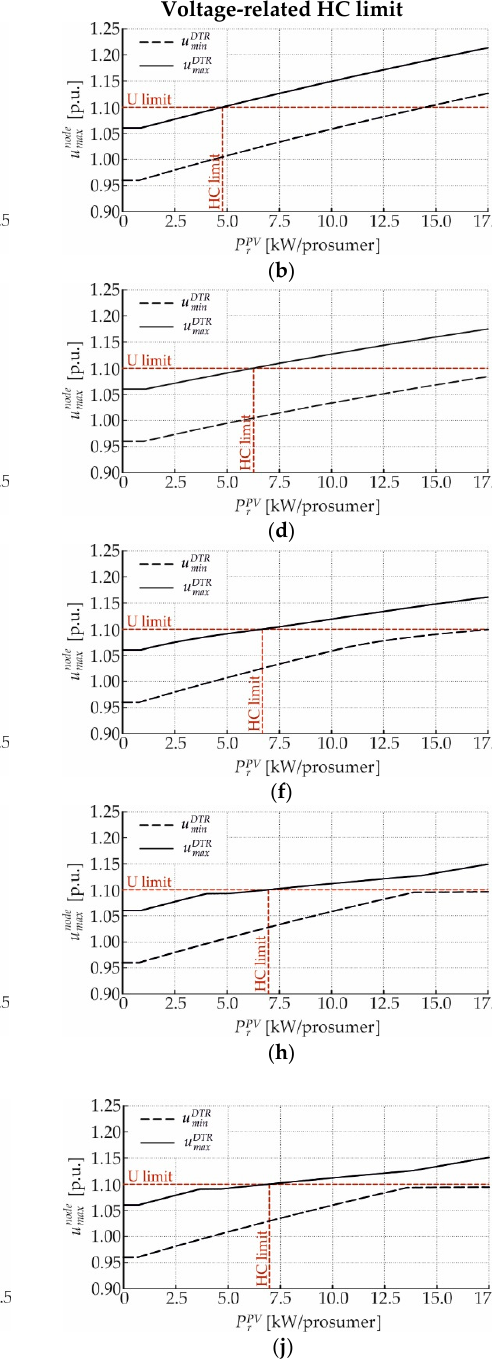
Figure 15. Current- and voltage-related hosting capacity limits of the branched cable test-feeder for different control strategies: ( a , b ) no-control; ( c , d ) cos φ ( P )-control; ( e , f ) Q ( U )-control; ( g , h ) L ( U )-control; ( i , j ) L ( U )-control and Q -Autarkic prosumers.